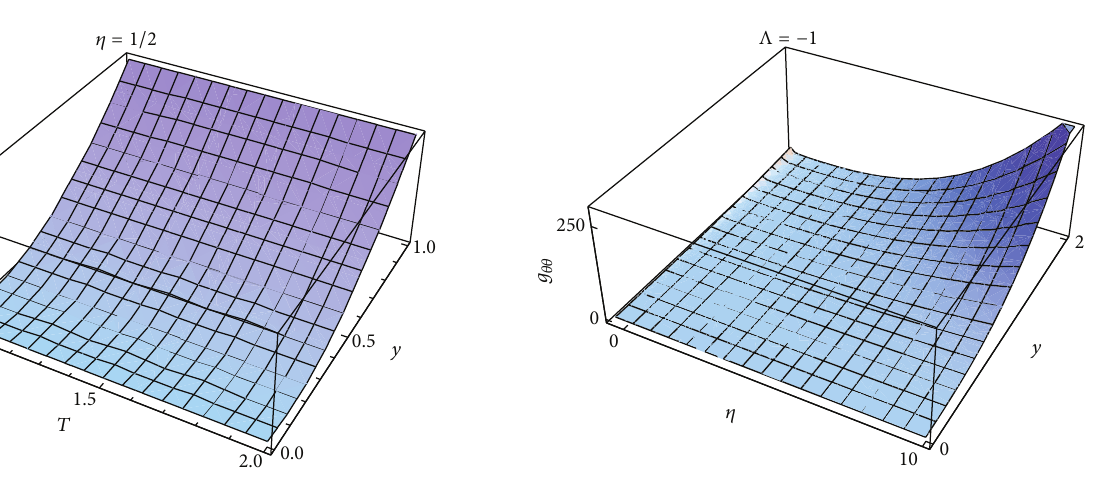
Figure 4: Black string warped horizon area 𝑔 𝜃𝜃 (𝑅,𝑦) along the extra dimension for Λ = −1 and the parameter 𝜂 variable.